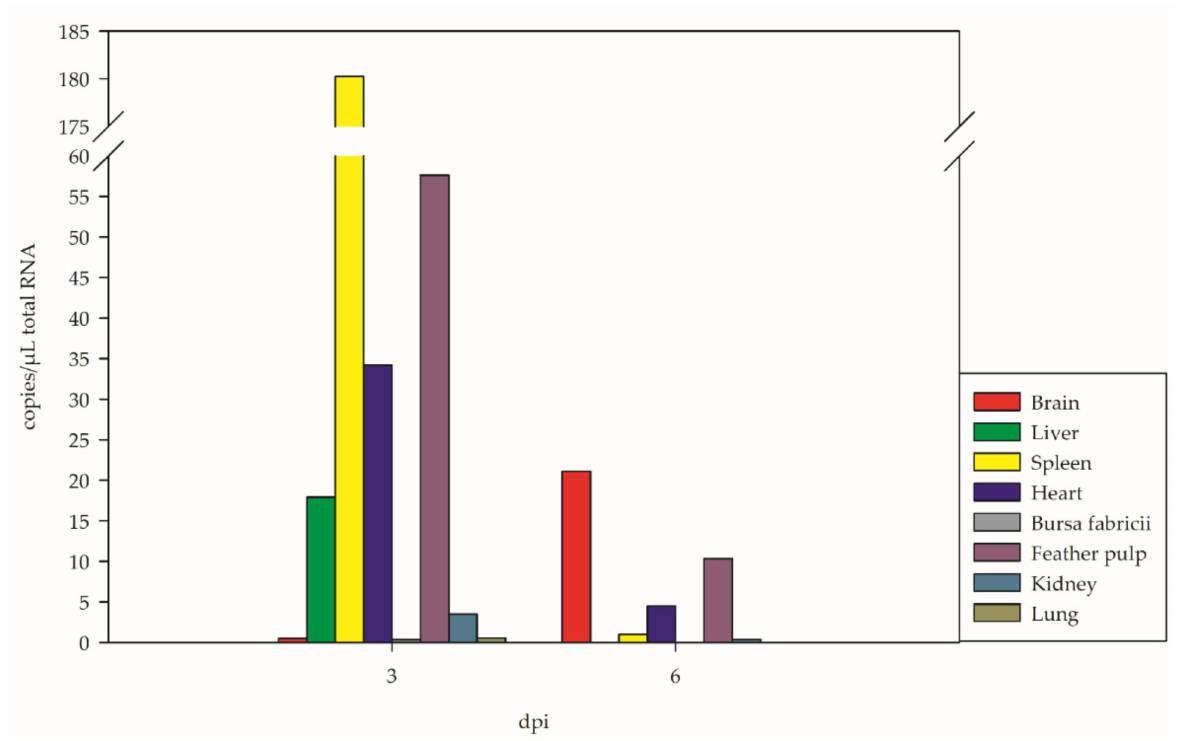
Figure 7. Viral distribution in different organs presented as the means of three WNV-inoculated geese each at 3 dpi and 6 dpi in copies/ µ L total RNA, as estimated by